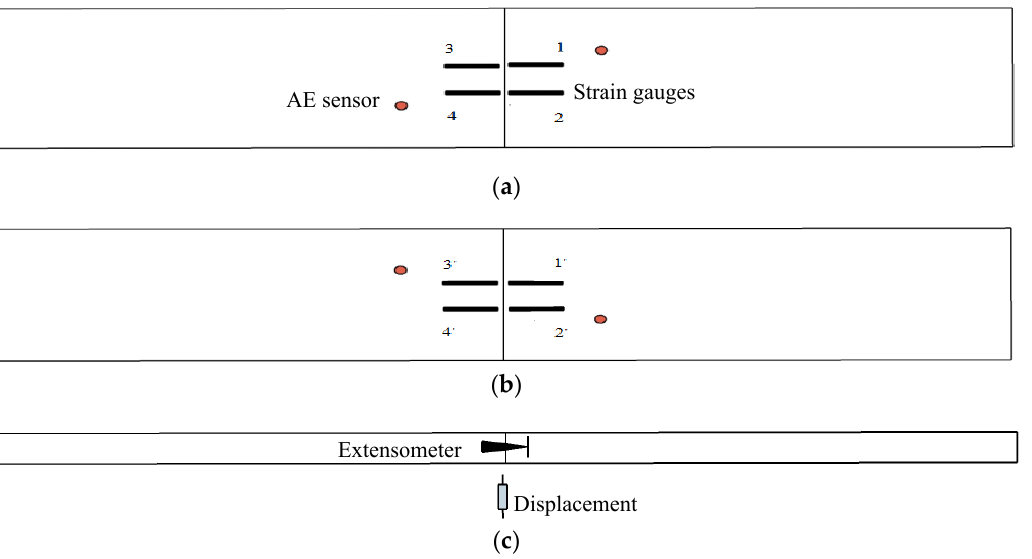
Figure 5. Sensor location: ( a ) Strain Gauge and Sensor Arrangement (outside); ( b ) Strain Gauge and Sensor Arrangement (inside); ( c ) Displacement and Extensometer.